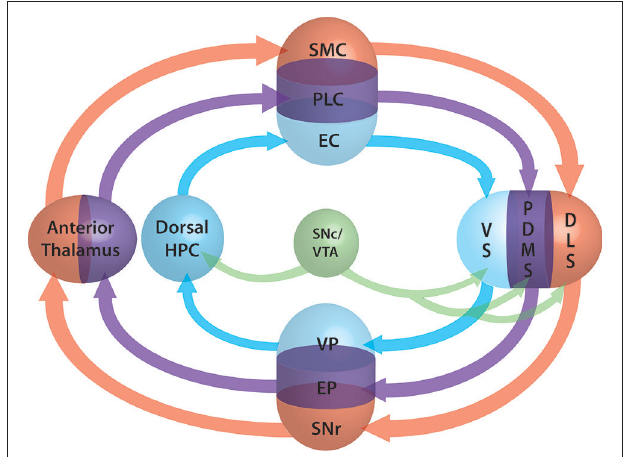
FIGURE 2 | Schematic representation of the three loops involved in spatial lnavigation . The loops are embedded in the fronto-cortical structures (SMC: sensorimotor cortex, PLC: prelimbic cortex, EC: entorhinal cortex), the basal ganglia (BG) segregated roughly into ventral (VS: ventral striatum, VP: ventral pallidum), dorsomedial (DMS: dorsomedial striatum, EP: entopeduncular nucleus) and dorsolateral (DLS: dorsolat- eral striatum, SNr: substantia nigra pars reticulata) parts, the anterior thalamus and the dorsal part of the hippocampus (Dorsal HPC). Dopamine projections from the SNc and ventral tegmantal area (VTA) are shown in green. The three functional loops are shown in blue for allocentric navigation by localization, in purple for allocentric navigation by external cues and in red for egocentric navigation. Convergence at BG level allows the system to perform selection of one of the modalities through a competition mechanism similar to those of the action selection loop (adapted form Retailleau et al.,